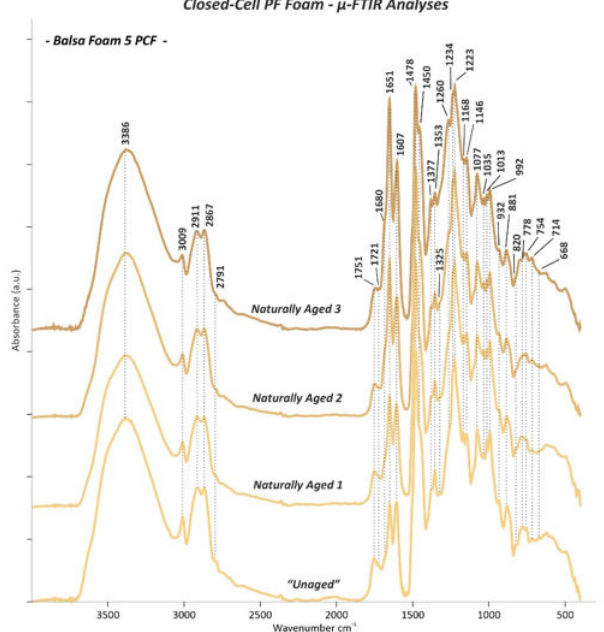
Figure 12. µ -FTIR spectra of the “Unaged” and Naturally Aged 1, 2 , and 3 Balsa foam 5 PCF closed-cell PF